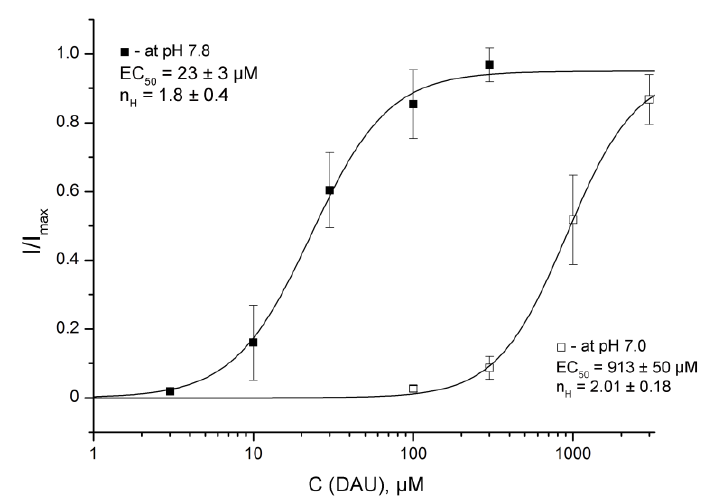
Figure 5. DAU-induced development of the second peak at conditioning pHs of 7.8 and 7.0. Dose–response curves for the second peak by DAU pre-incubation at the holding pHs of 7.8 and 7.0 were plotted for same pH 5.5 activating stimulus. I / I max is the second peak’s amplitude at a conditioning pH of 7.8 or 7.0, normalized to the maximum amplitude (I max ), which we calculated for each oocyte via individual fitting. Data are presented as mean ± SEM (n = 6).